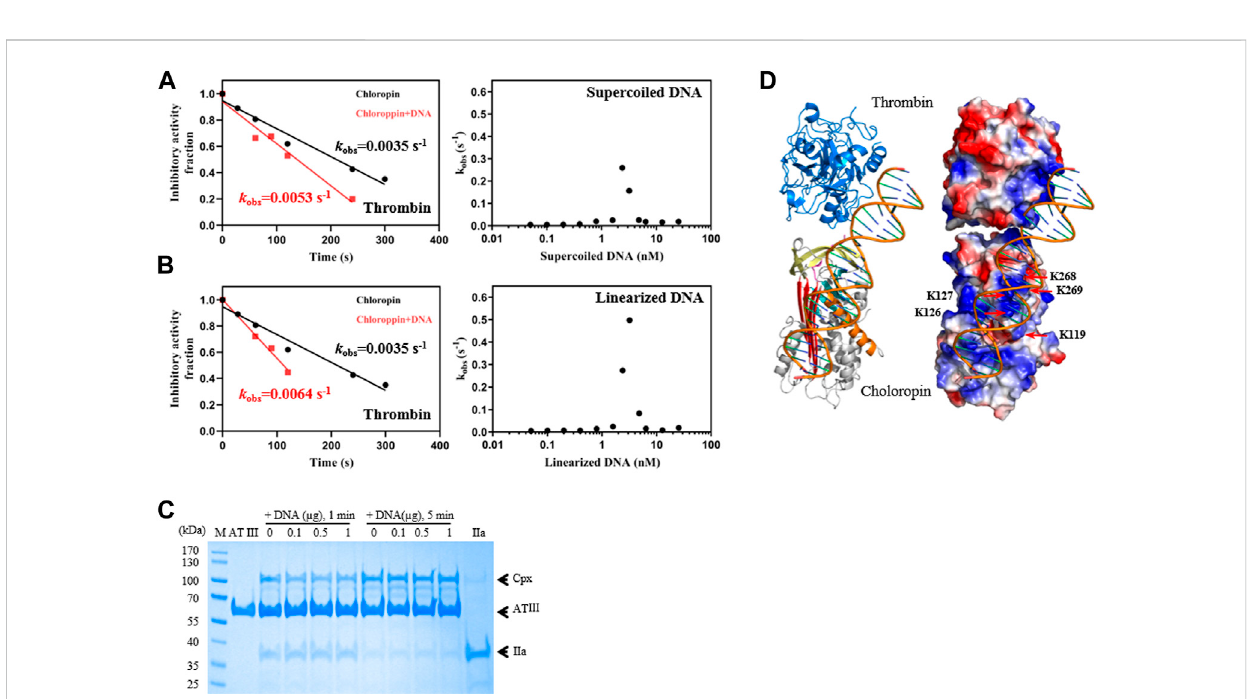
FIGURE 3 DNA promoted the inhibition of thrombin by chloropin. (A) Supercoiled plasmid DNA (0.1 nM) accelerated thrombin inhibition (left) and the acceleration was DNA concentration-dependent and followed a bell-shaped curved (right). Chloropin (375 nM) in the presence or absence of 0.1 nM DNAwasincubatedwith75 nMthrombinfordifferenttimeintervalswiththeremainingproteaseactivityplottedtoobtain k obs .The k obs valuesatdifferent concentrations of DNA (0.05, 0.1, 0.2, 0.4, 0.8, 1.6, 2.4, 3.2, 4.8, 6.4, 12.8, 25.6 nM) were plotted as ascatter chart(right). (B) Similar acceleration was alsoobservedwithlinearplasmidDNA. (C) TheeffectofDNAonthethrombininhibitionbyantithrombin.DifferentamountsofDNA(0,0.1,0.5,1 µg)were incubated with 2 µg antithrombin and 0.5 µg thrombin for 1 min and 5 min respectively, and the samples were then analyzed by SDS-PAGE. Cpx, antithrombin-thrombincovalentcomplexes;IIa,thrombin. (D) Acartoonofthechloropin-thrombin-DNAternarycomplexshowingtherelativepositions of thrombin and chloropin. DNA is expected to bind the positively charged surface areas of thrombin and chloropin simultaneously and promote thrombin